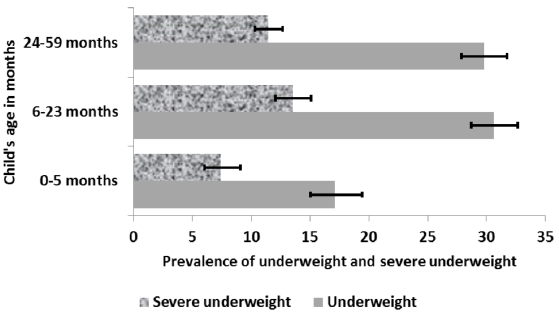
Figure 3. Prevalence of underweight and severe underweight by child’s age in months.